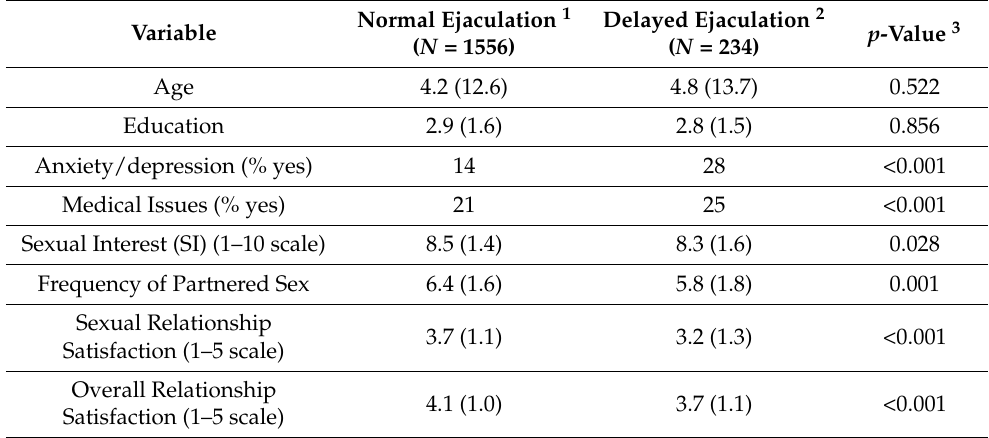
Table 1. Descriptions (mean ± SD) of men with normal ejaculatory response and men with de- layed/inhibited ejaculation (DE) on demographic and sexual/relationship variables.